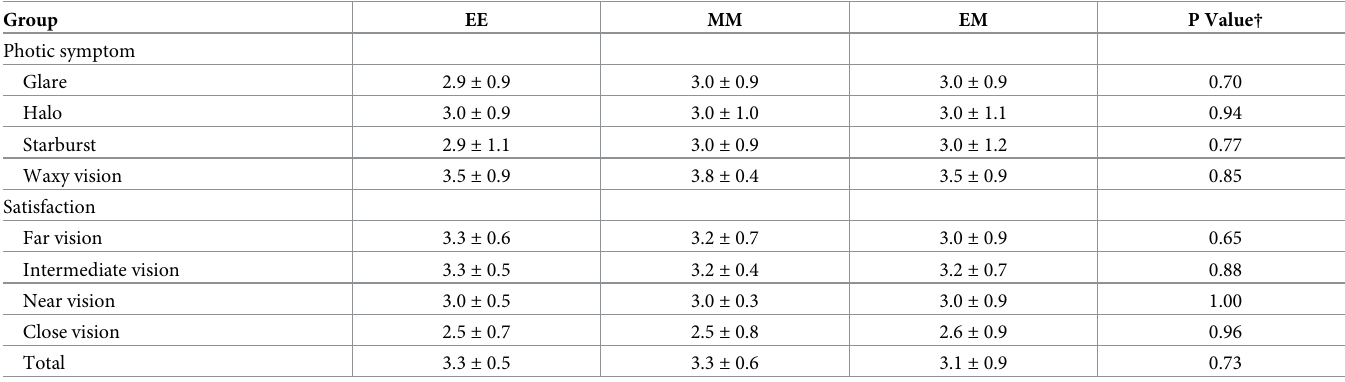
Table 3. Mean scores of photic symptom and patient satisfaction � .